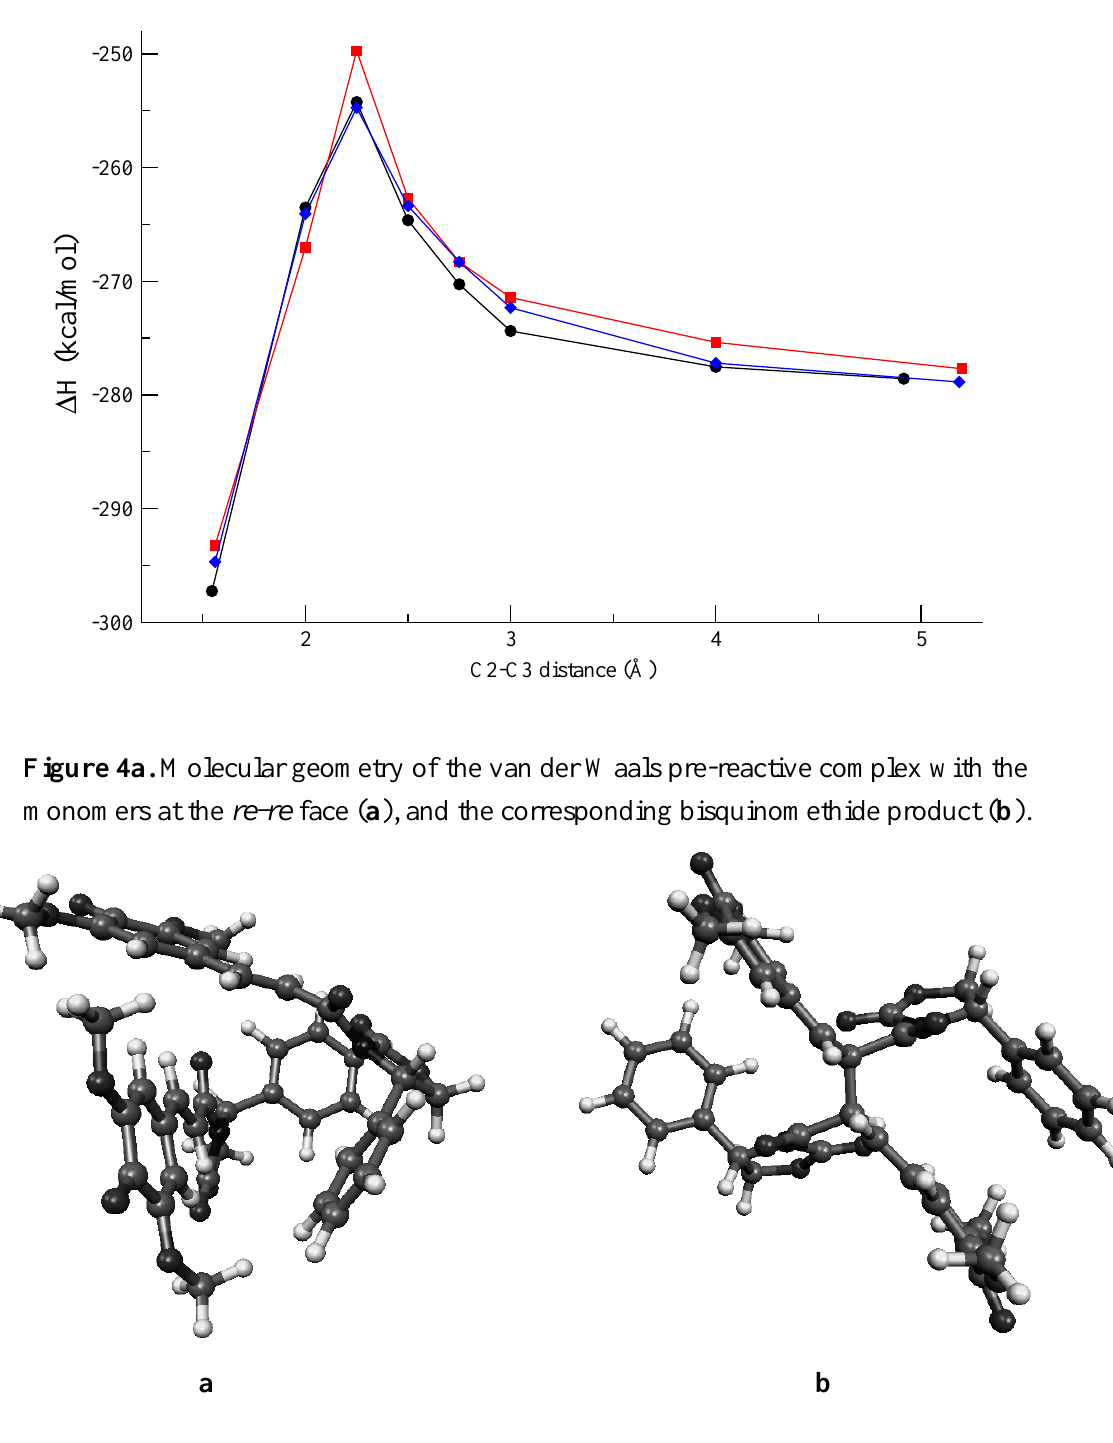
Figure 3. Reaction profile of the β - β oxidative coupling of two quinometide radicals 6 at the re-re ( ● - ● ), si-si ( ■ - ■ ), and re-si ( ♦ - ♦ ) faces.